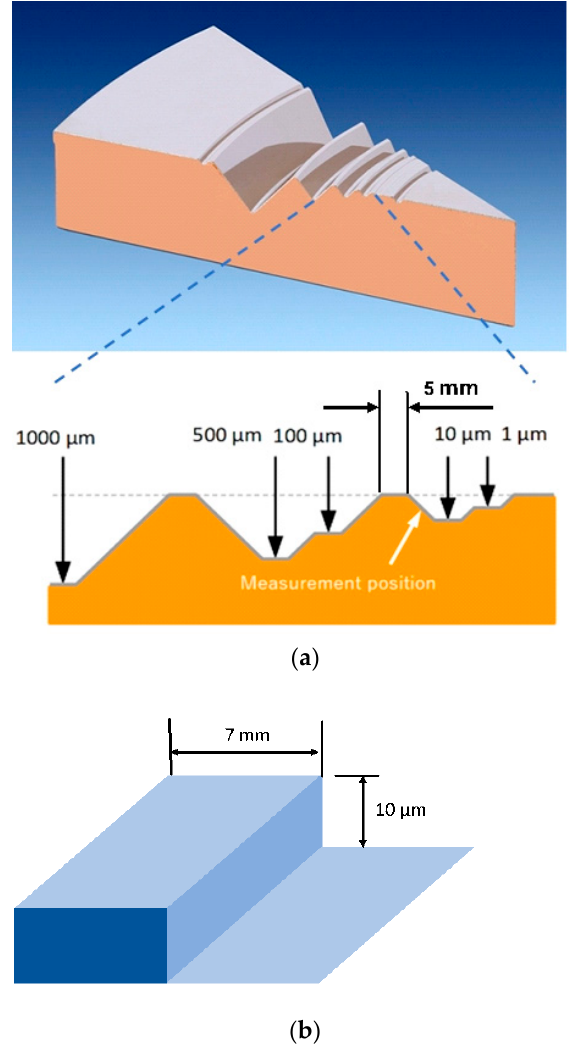
Figure 7. Artifacts used in ”tip flight” test. ( a ) artifact A; ( b ) artifact B. The artifacts aren’t drawn to